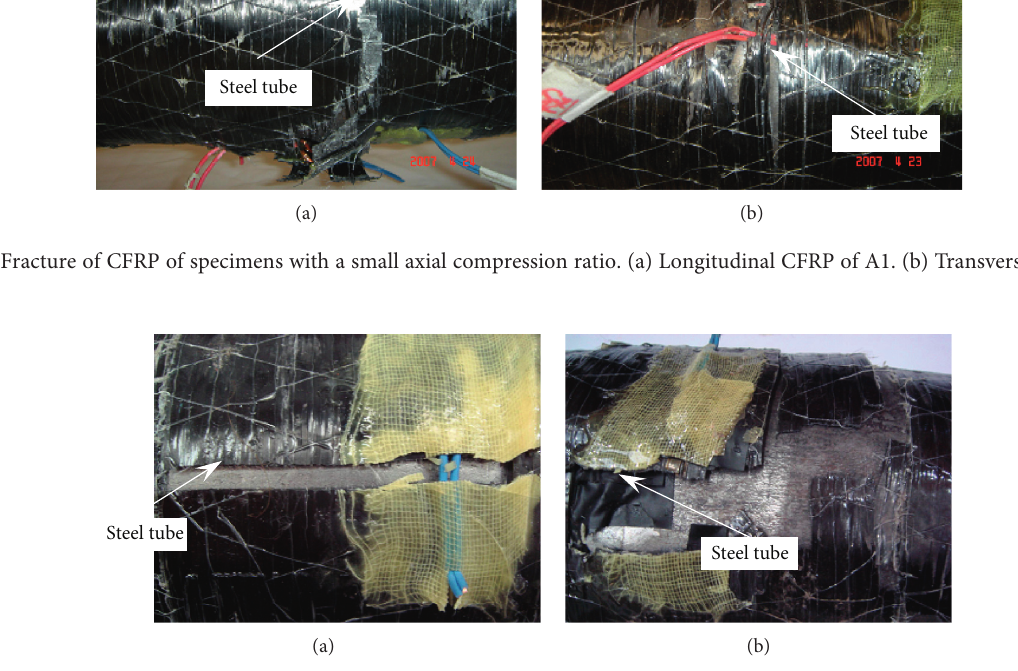
Figure 6: Fracture of CFRP of specimens with a large axial compression ratio. (a) Longitudinal CFRP of C1. (b) Transverse CFRP of C0.